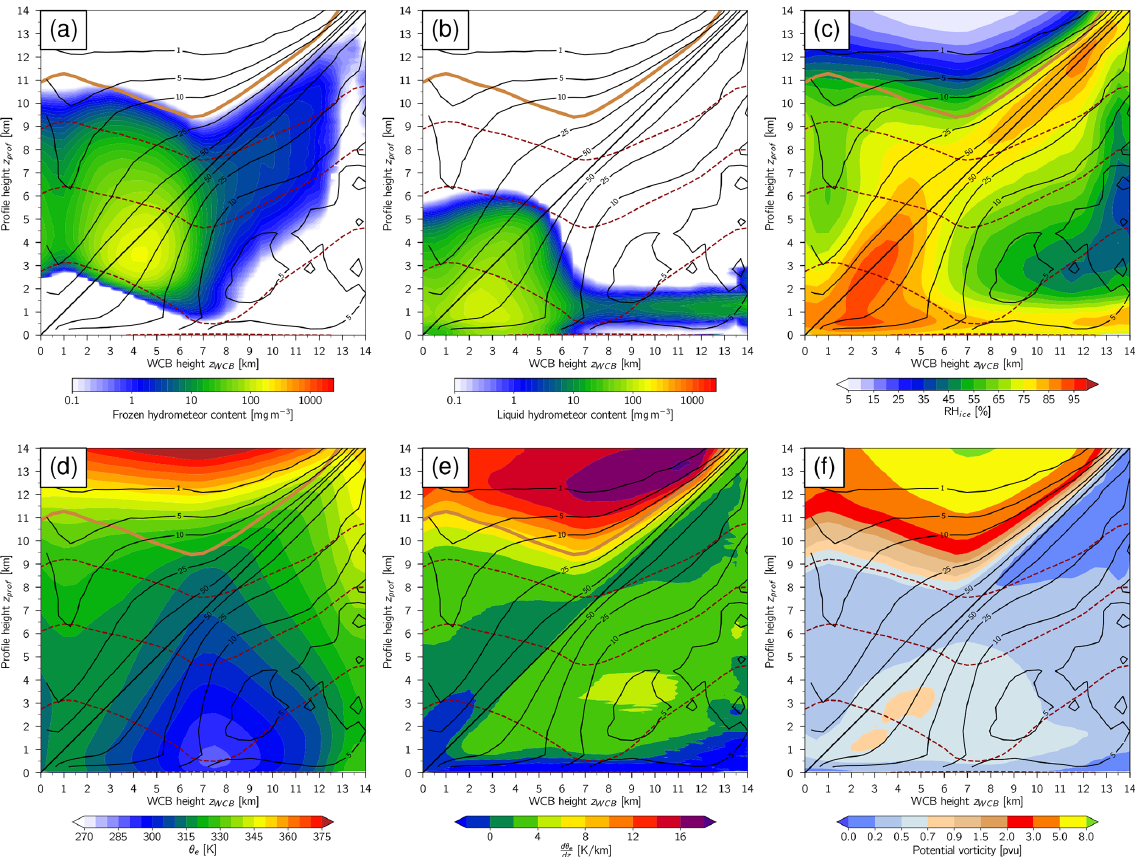
Figure 6. Composite over all WCBs of the (a, b) median and (c–f) mean vertical profiles of ERA5 fields separately for different height bins of the matching WCB air parcels. The shading shows (a) the frozen hydrometeor content (mgm − 3 ), i.e. the sum of the prognostic cloud ice and snow water contents, (b) the liquid hydrometeor content (mgm − 3 ), i.e. the sum of the prognostic cloud liquid water and rain water contents, (c) relative humidity with respect to ice (%), (d) θ e (K), (e) moist vertical stability d θ e / d z (Kkm − 1 ), and (f) PV (pvu). The black and brown contours are as in Fig.